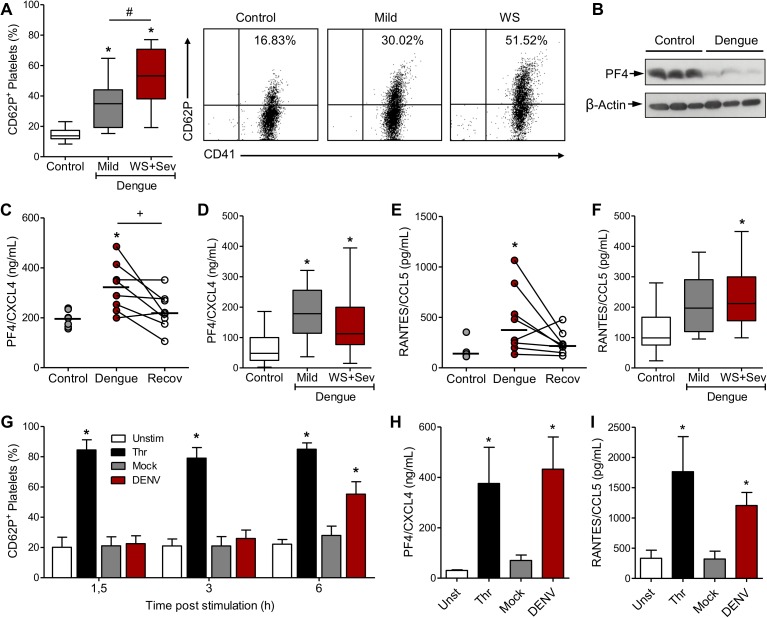
Dengue triggers platelet activation and chemokine secretion.(A) P-selectin (CD62P) surface expression by platelets isolated from healthy volunteers (Control) and patients with mild dengue, dengue with warning signs (WS) and severe dengue (Sev). (percentage of positive cells by flow cytometry). Boxes indicate the median and interquartile ranges and whiskers indicate minimal and maximal values in each group. Representative dot plots are shown. (B) Western blot analysis of platelet factor 4 (PF4/CXCL4) and β-actin in platelets isolated from three control subjects and three patients with dengue. (C and E) PF4/CXCL4 and RANTES/CCL5 concentration in supernatants of platelets (1 x 109 per mL) from 8 control subjects and 8 dengue patients that were cultured for 4h ex vivo. Platelets obtained from the same patients in the recovery phase (Recov) were also evaluated. Each dot represents the level of chemokines secreted by platelets from one dengue patient or control. Horizontal lines represent median. (D and F) Concentration of PF4/CXCL4 and RANTES/CCL5 in plasma from control subjects and patients with dengue. Boxes indicate the median and interquartile ranges and whiskers indicate minimal and maximal values in each group. (G-I) Platelets isolated from healthy volunteers were kept unstimulated (Unst) or stimulated with thrombin (Thr), DENV or Mock for the indicated times. Panel G shows the percentage of CD62P-expressing platelets, and panels H to I show the concentration of PF4/CXCL4 and RANTES/CCL5 in the supernatant of platelets incubated in each condition for 6h. Bars represent mean ± standard error of the mean of 4 to 8 independent experiments performed with platelets from individual donors.* means p<0.05 compared to Control, Unst or Mock; # indicates p<0.05 between patients with mild and WS+Sev dengue syndromes; + represents p<0.05 between dengue patients in the acute and recovery phase (paired t test).